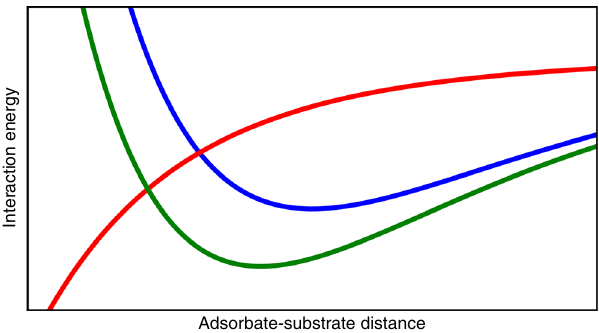
Fig. 9 Interaction energy of metal orbitals with an adsorbate. The contributions from the d -band ( Δ E d ; red) and sp -band ( Δ E sp ; blue) combine to make the total adsorption energy ( Δ E ads ; green). The illustration is representative of interaction energies for atomic oxygen with the